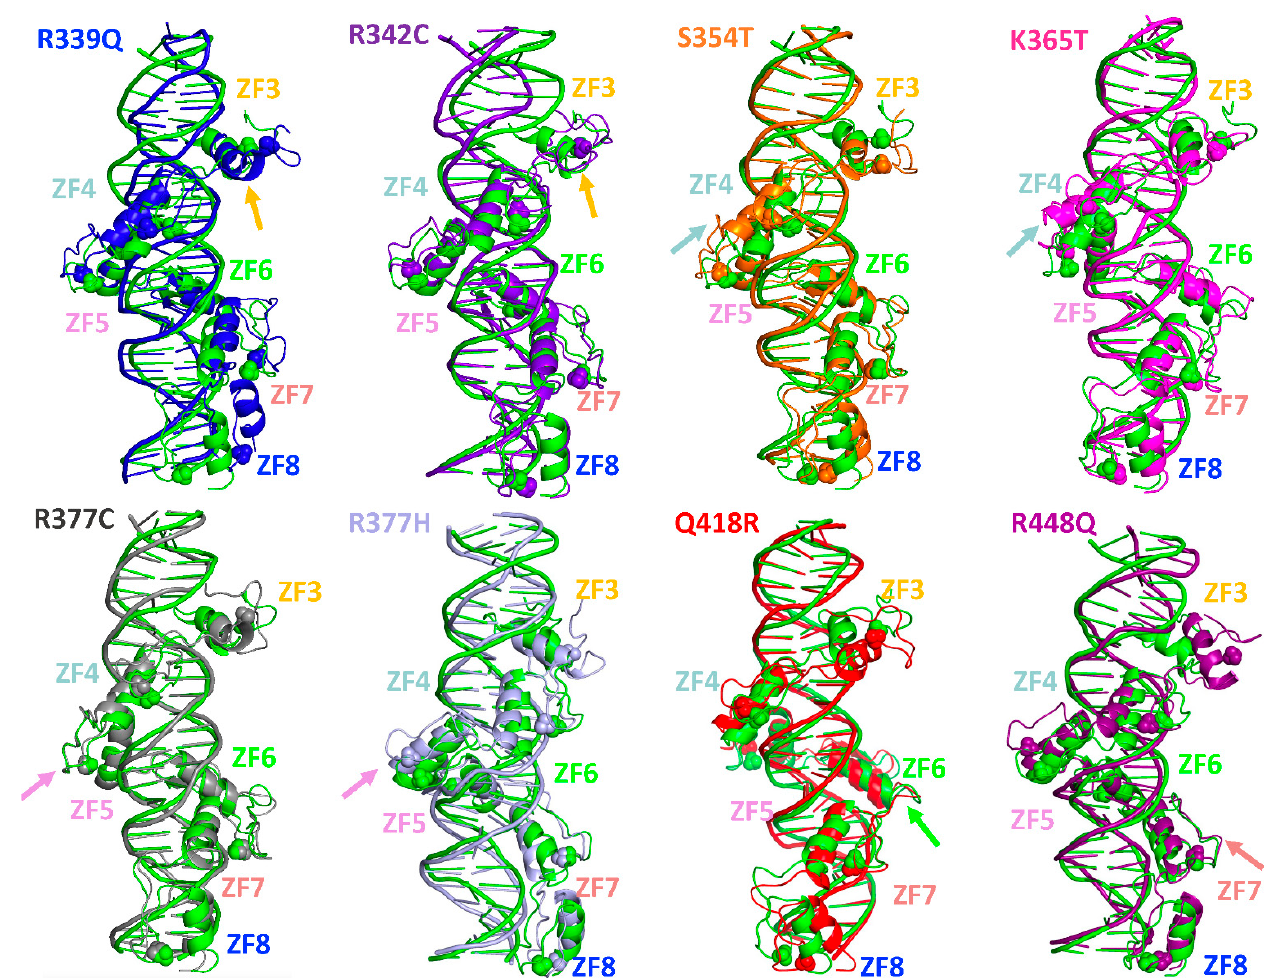
Figure 4. CTCF secondary and tertiary structure is impacted by single-residue mutations. Shown for each mutant is the representative structure of the most populated cluster among its five independent trajectories. Alignment is based on the wildtype protein (green) and each mutant, with arrows indicating the position of each mutation.